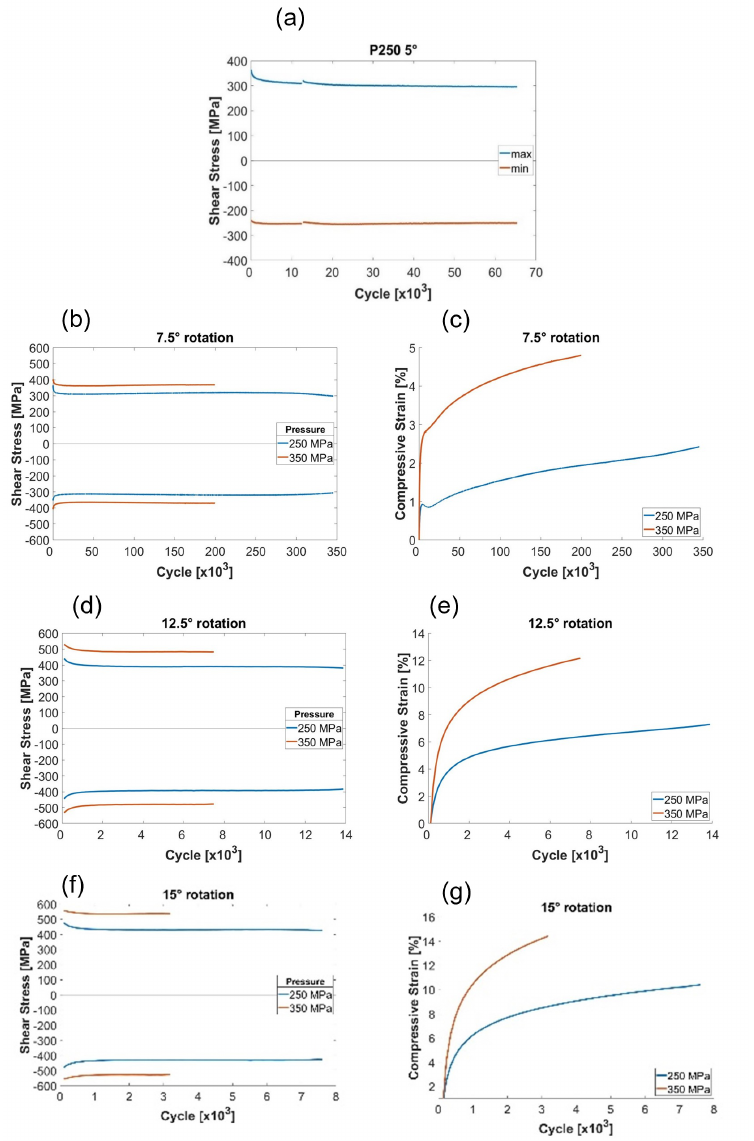
Figure 6. Evolution of shear stress and compressive strain over the duration of experiments for 250 MPa and 350 MPa compressive stress. ( a ) 250 MPa and 5 ◦ , ( b , c ) 7.5 ◦ , ( d , e ) 12.5 ◦ and ( f , g ) 15 ◦ torsional